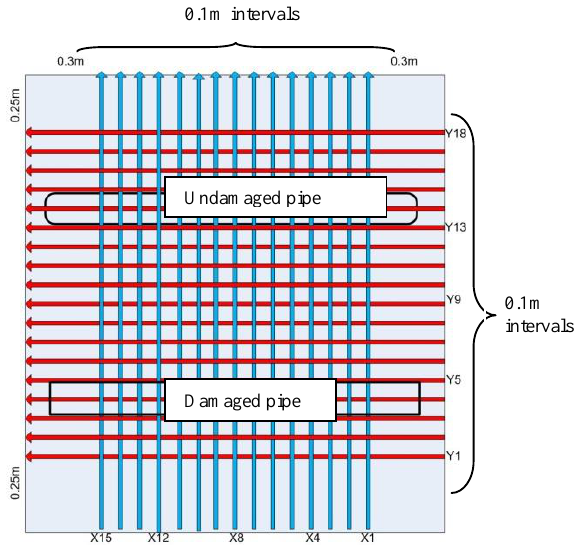
Figure 6: Survey grid lines used for each experiment